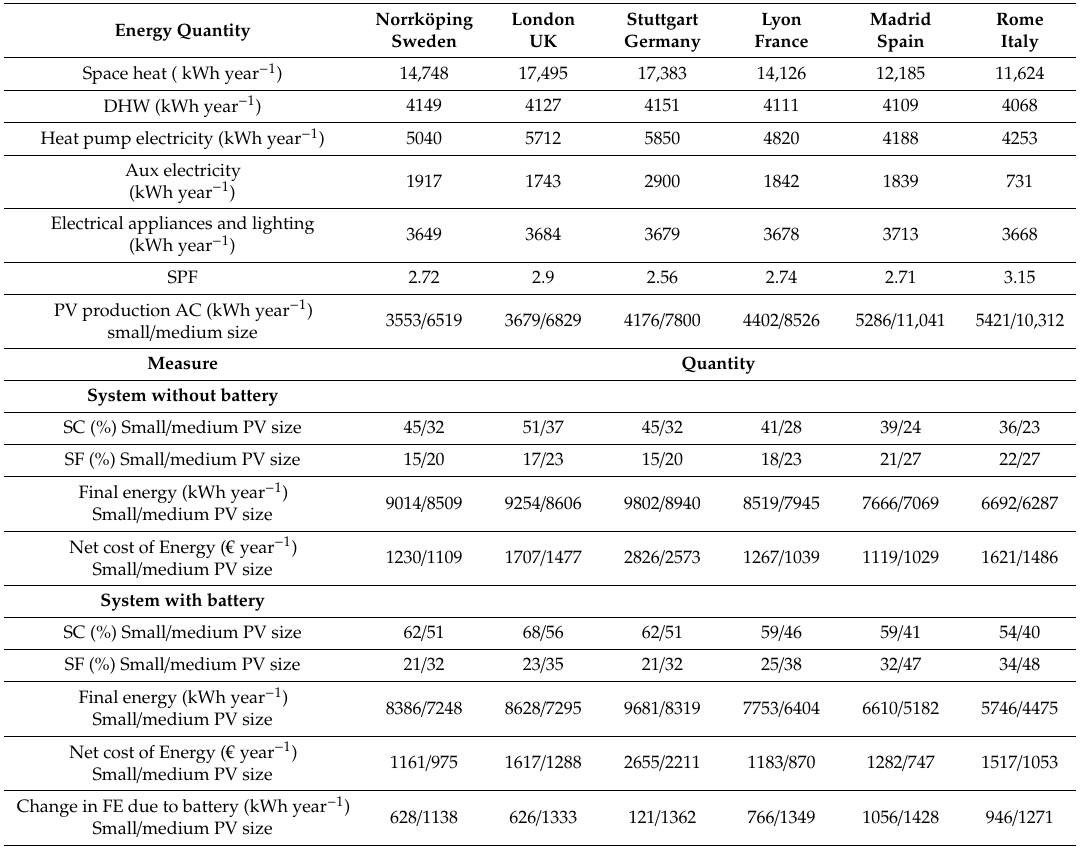
Table 8. Overview of the key performance indicators for a complete year for the reference system for the various examined boundary conditions with and without electrical storage (for the medium load profile 4P and 21 ◦ C setpoint and the two PV system